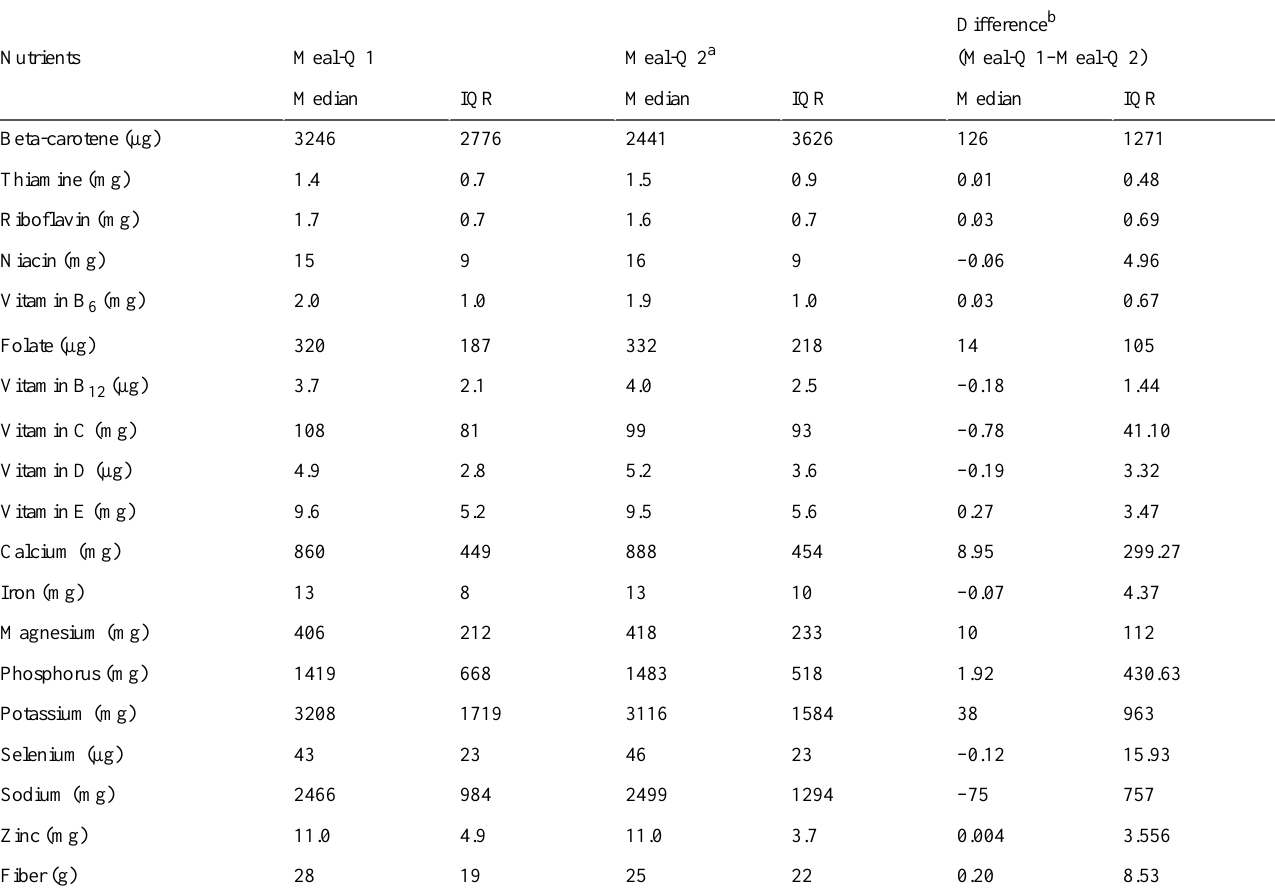
Table 6. The median and interquartile range (IQR) of daily micronutrient and fiber intake assessed with Meal-Q 1 and Meal-Q 2 from group 2, and the median (IQR) difference in intake between the questionnaires